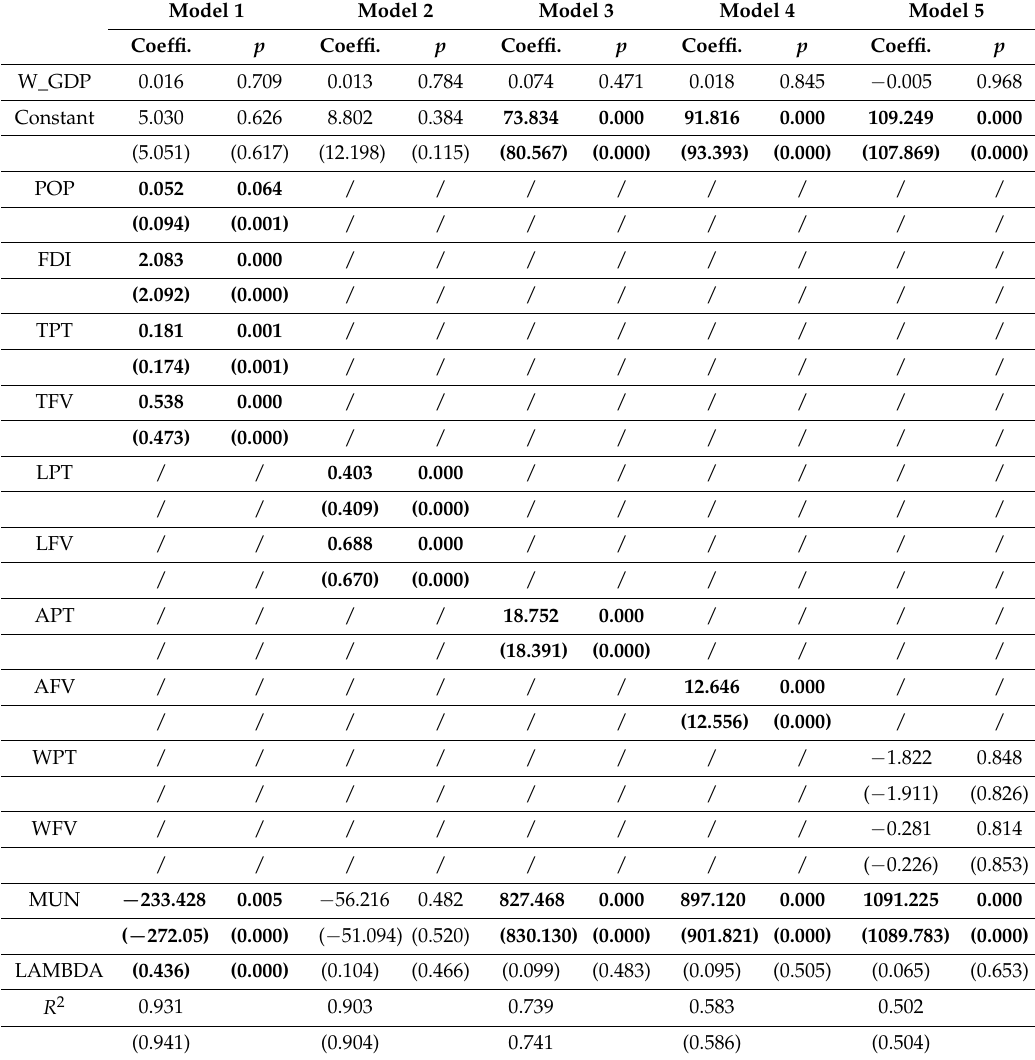
Table 8. SLM/SEM estimation results for the western